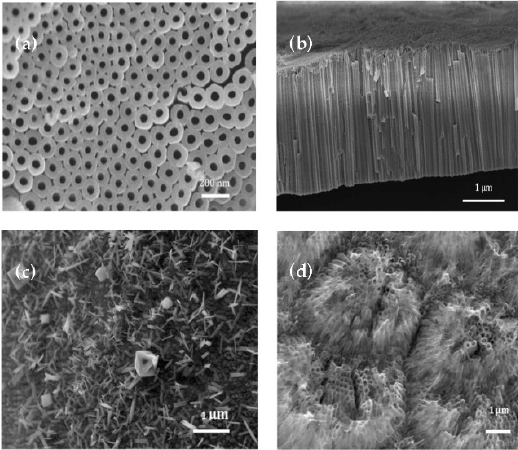
Figure 1. SEM images of TiO 2 NT electrodes ( a ), top view of TiO 2 NT anodized at 60 V 15 °C, annealed; ( b ) side view of TiO 2 NT anodized at 60 V 15 °C, annealed; ( c ) top view of TiO 2 NT anodized at 60 V 5 °C, non-annealed; ( d ) top view of TiO 2 NT anodized at 60 V 35 °C, non-annealed).